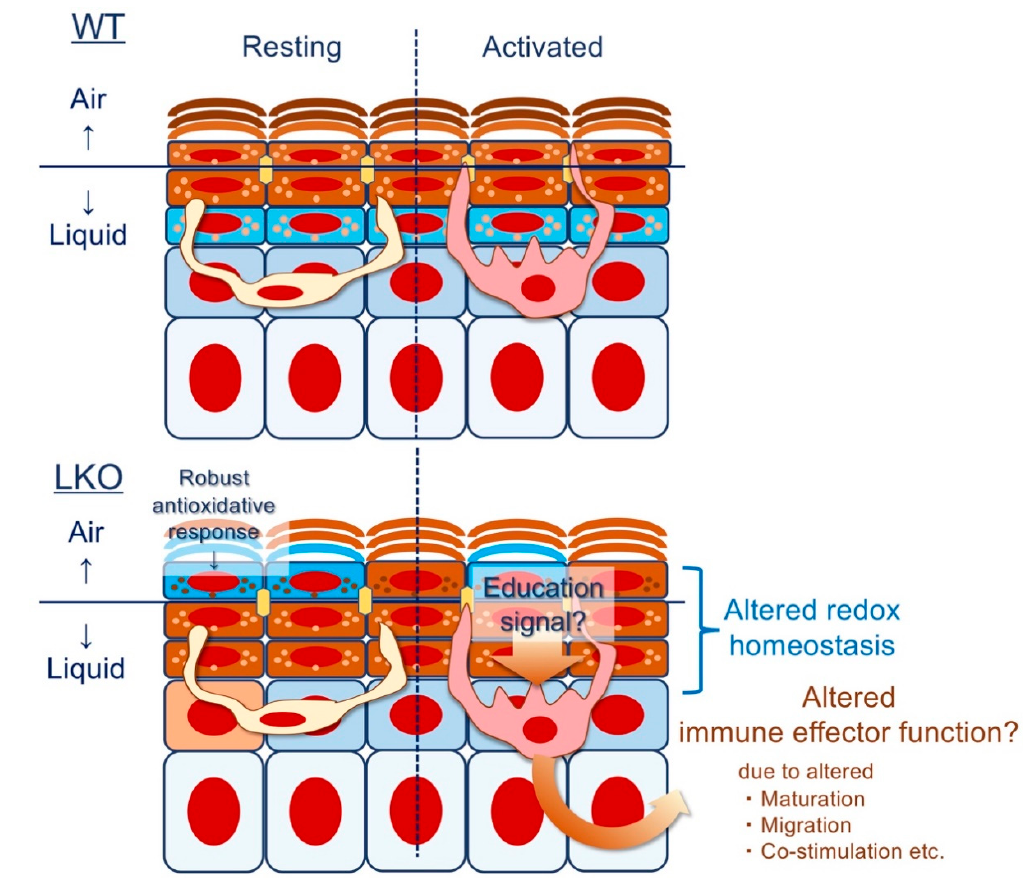
Figure 5. Epithelial imprinting of immunological memory: does LOR instruct the Langerhans cell (LC)? Epidermal Langerhans cells (LC) express tight junction proteins, project dendrites, and sample self-antigens and foreign antigens in the steady state. Loricrin knockout (LKO) epidermis exhibits a robust anti-oxidative response upon exposure to the ambient air, and keratinocyte antioxidants such as small proline-rich proteins (SPRR) or late cornified cell envelope (LCE) are upregulated. However, both SPRR and LCE cannot fully compensate for the biochemical property of loricrin (higher-order structure that enable a prompt intra- or inter-molecular disulfide formation); therefore, redox homeostasis (or metabolic environment) would be profoundly affected in the absence of loricrin. The altered epidermal microenvironment could condition LC (or other dendritic cell subsets) to limit an excessive inflammatory response.